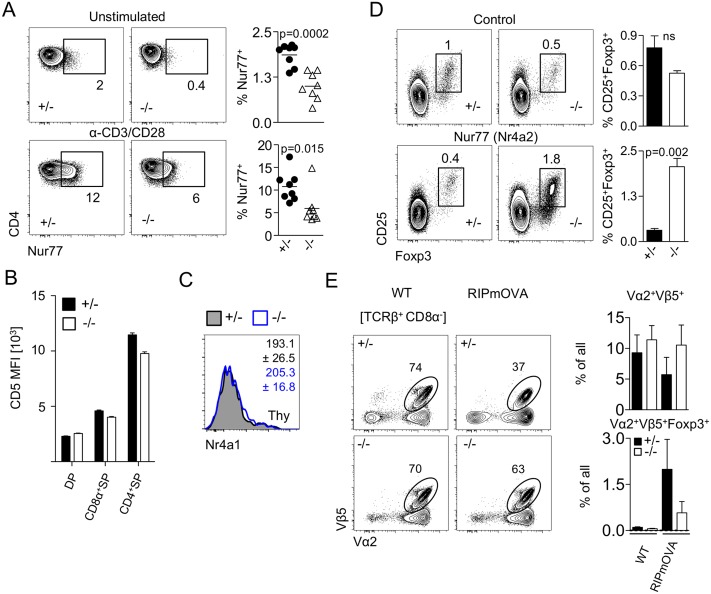
TCR signal strength determines miR-181a/b-1–dependent Treg-cell development.(A) Expression of Nur77 in DP thymocytes in the absence of miR-181a/b-1. Unstimulated or stimulated (3 h, 37 °C, αCD3/CD28 2.5 μg/ml) thymocytes from miR-181a/b-1 het and KO mice were stained for intracellular Nur77. Plots are representative of 2 independent experiments with n = 3–4 for each genotype. Graphs show frequencies of Nur77-positive cells for indicated conditions in CD4+CD8α+ DP thymocytes. (B) Reduced CD5 expression in the absence of miR-181a/b-1 mirrors impaired TCR signaling. Data from 2 independent experiments with n = 8–9 per group. (C) RNA flow-cytometry analysis of the expression of Nr4a1 (encoding Nur77) by TCRβ+CD4+Foxp3+ tTreg cells. Numbers indicate average MFI ± SD. Data from 2 independent experiments with n = 2–3 per experiment. (D) Overexpression of Nr4a2 (Nur77 family) rescues development of Treg cells deficient for miR-181a/b-1. LSK cells from OT-II × miR-181a/b-1+/− or OT-II × miR-181a/b-1–/–mice were sorted and transduced with a retrovirus expressing a chimeric Nr4a2 molecule in which the Nr4a2 LBD is replaced by that of a mutant human estrogen receptor-α (Nr4a2-ΔLBD-ERT2) or ctrl retrovirus. Cells were injected into lethally irradiated WT recipients, and 7 weeks later, expression of Nr4a2 was induced via tamox administration for 5 consecutive days before analysis. Plots depict frequencies of Treg cells generated from precursor cells transduced with ctrl vector (upper panels) and from precursors transduced with vector carrying inducible Nr4a2 (lower panels). Graphs show summary of the results from 2 independent experiments, with n = 3 for each genotype and condition. (E) Less efficient clonal deletion and Treg-cell formation in the absence of miR-181a/b-1. OT-II × RIPmOVA chimeras were generated after lethal irradiation of RIPmOVA recipient mice (ctrl: WT/WT; transgenic: tg/WT) and injection of OT-II × miR-181a/b-1+/− or OT-II × miR-181a/b-1−/− BM cells. Mice were analyzed after 8 weeks. Plots depict frequencies of Vα2+Vβ5+ OVA-specific donor cells in ctrl and tg recipients, which express OVA during negative selection. Graphs show summary of this analysis (upper panel) and absolute numbers as well as frequencies of Vα2+Vβ5+Foxp3+ Treg cells generated in the presence or absence of miR-181a/b-1 (lower panels). Data are representative of 2 independent experiments with n = 6–9 for each recipient/donor combination. Statistical analysis was performed using unpaired Student’s t test (A, C, D). Numerical values are available in S1 Data. BM, bone marrow; CD, cluster of differentiation; ctrl, control; DP, double positive; ERT2, tamoxifen-inducible estrogen receptor 2; Foxp3, forkhead box protein P3; LBD, ligand-binding domain; LSK, lineage-negative, stem cell antigen-1-positive, Kit-positive; MFI, mean fluorescence intensity; miR-181, microRNA-181; Nr4a1, Nuclear receptor subfamily 4 group A member 1; Nur77, Nuclear hormone receptor NUR/77 encoded by Nr4a1; OT-II, ovalbumin-specific MHC class II-restricted alpha beta TCR; OVA, chicken ovalbumin; prec, precursor; RIPmOVA, rat insulin-promoter–driven membrane-bound chicken ovalbumin; SP, single positive; tamox, Tamoxifen; TCR, T-cell receptor; tg, transgenic; Treg cell, regulatory T cell; WT, wild type.